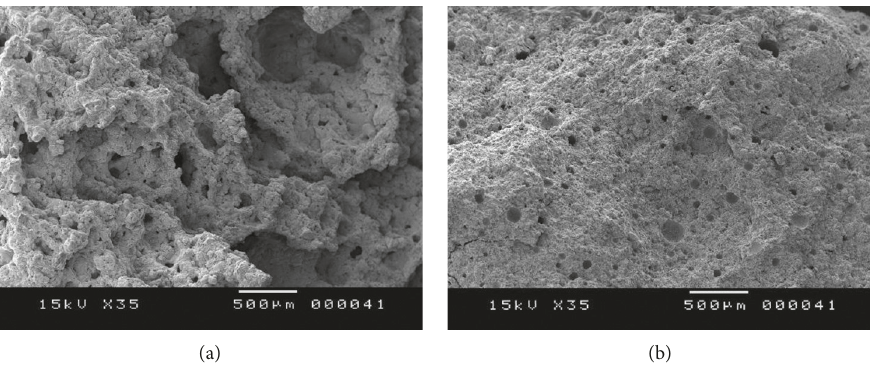
Figure 9: SEM pictures of (a) geopolymer foam M5 and (b) geopolymer cement